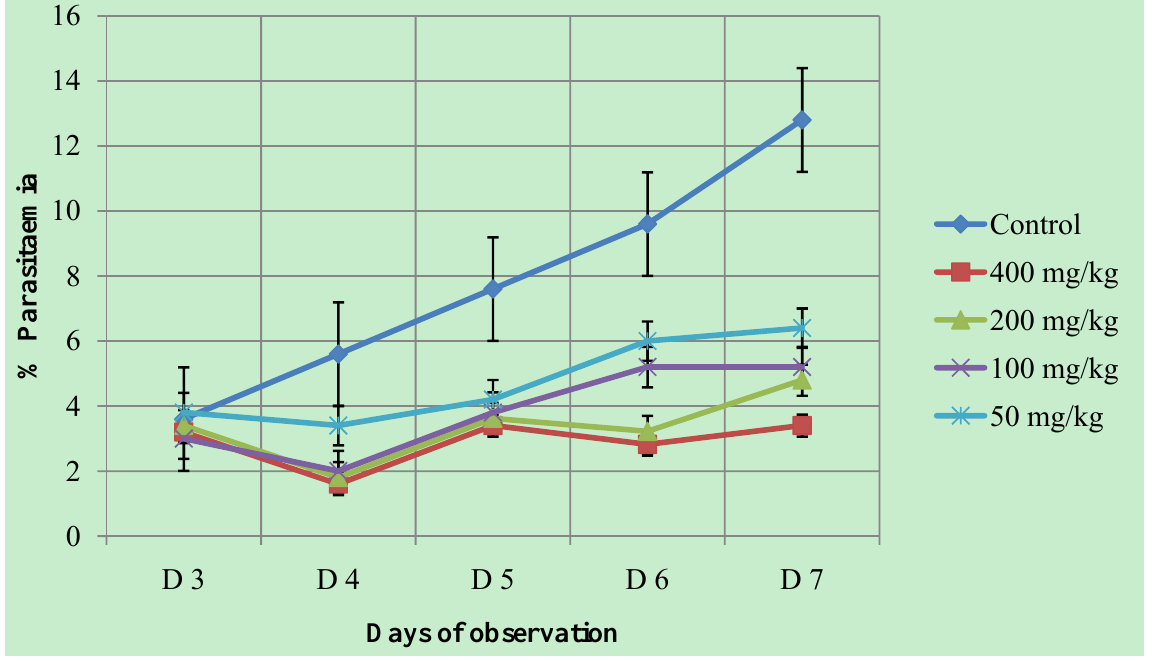
Figure 3. Comparison of parasitaemia chemosuppression of the extract-treated groups and control from D3 until D7 after